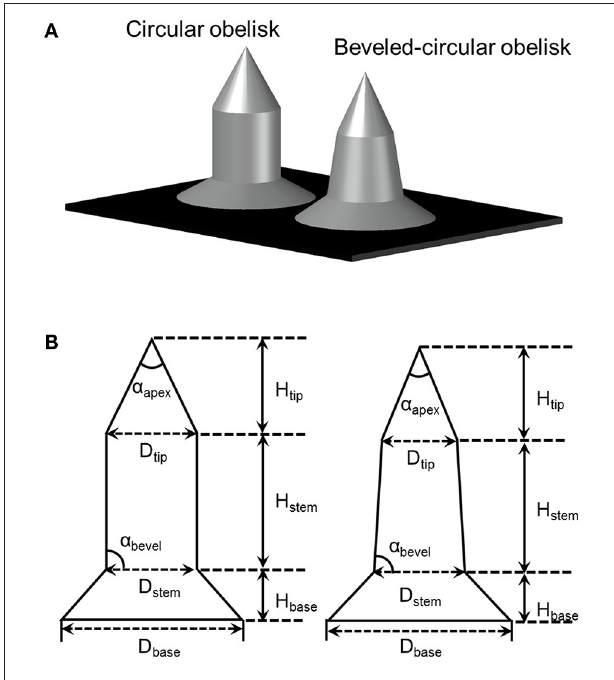
FIGURE 2 | (A) Illustration of obelisk-type microneedles. (B) Dimension parameters of circular (left) and beveled-circular (right) obelisks.